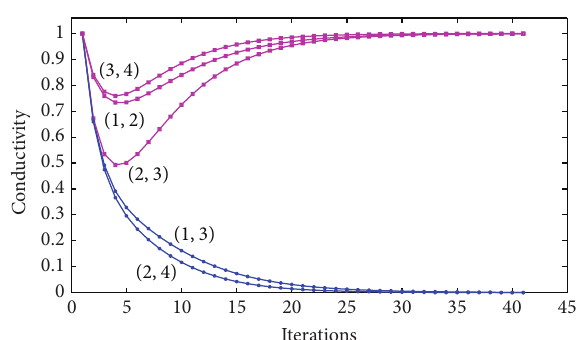
Figure 2: The changing trend of the conductivity associated with every